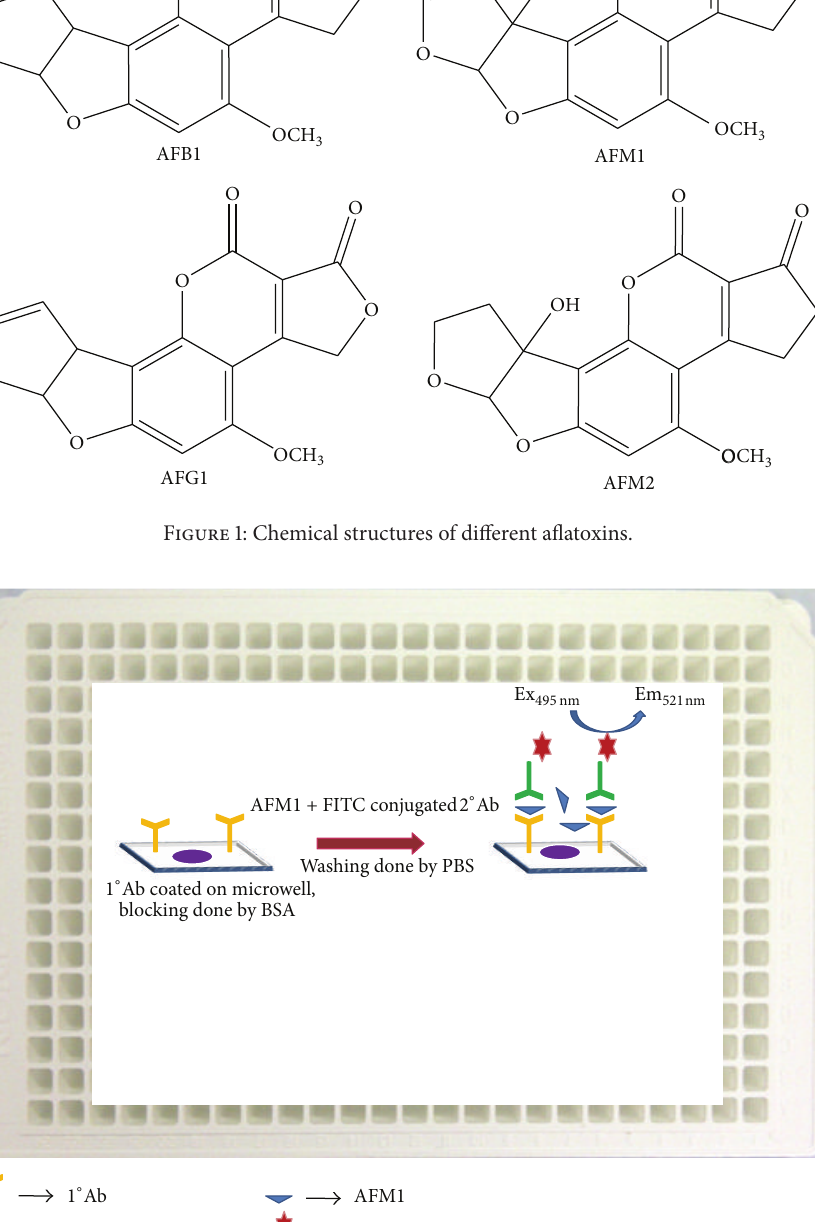
divided into 2 fractions. The first fraction containing 40 𝜇